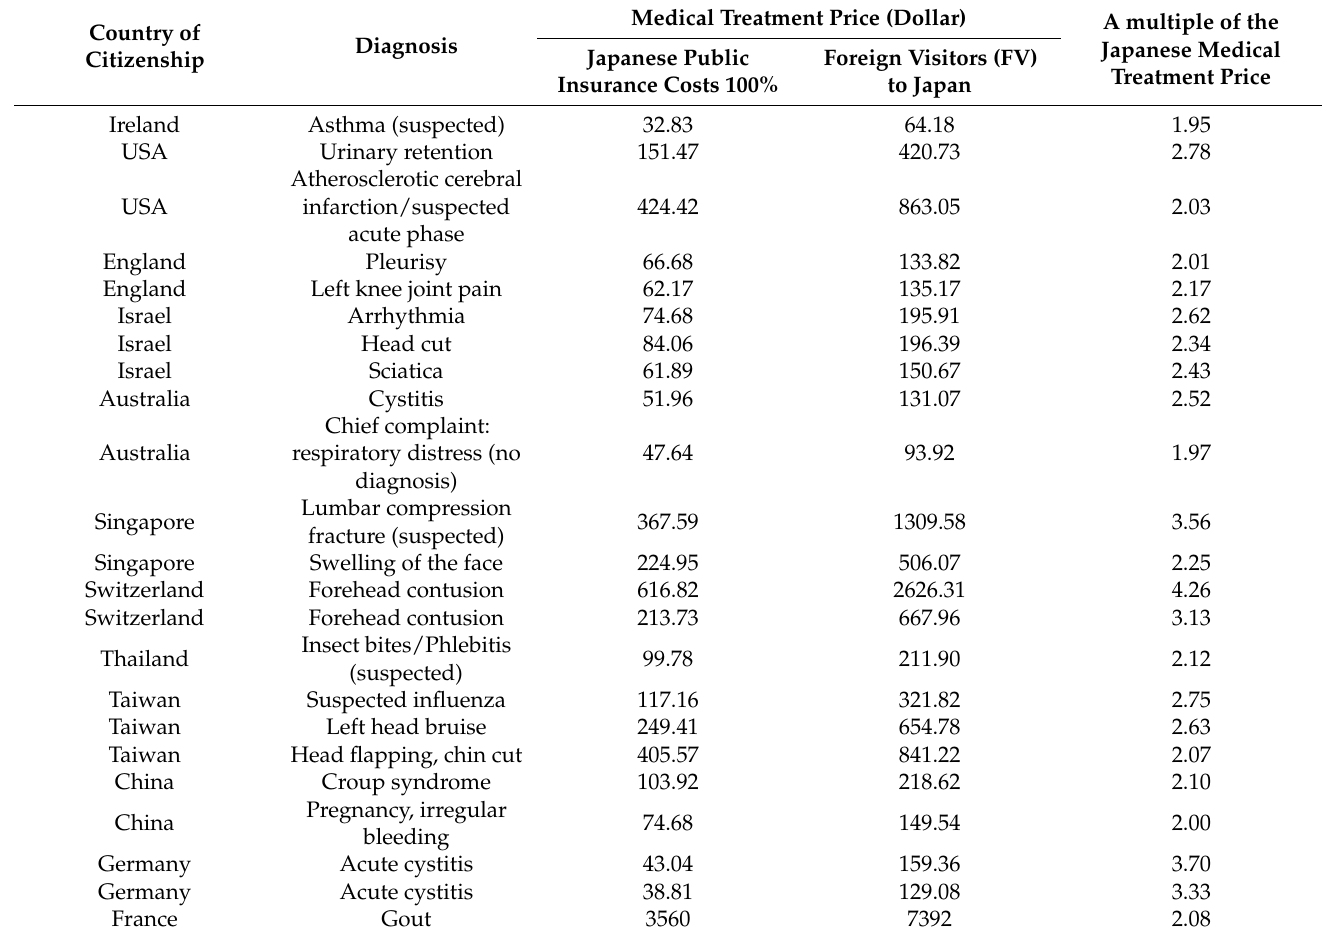
Table 1. Difference between calculated price of FVs and public-insurance price for Japanese nationals in the extended survey (including